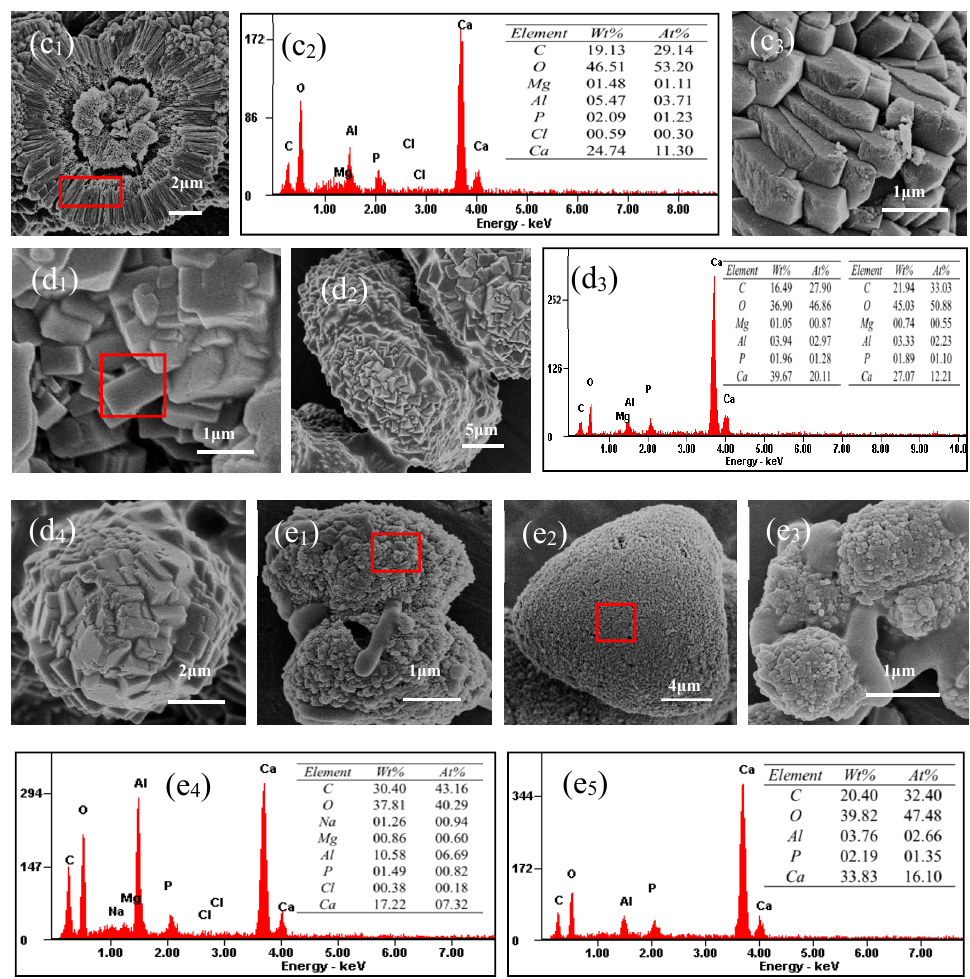
Figure 7. SEM and EDS analyses of minerals in MgCl 2 medium at different Mg/Ca ratios. ( a1 – a3 ) Mg/Ca ratio of 0; ( b1 – b3 ) Mg/Ca ratio of 2; ( c1 – c3 ) Mg/Ca ratio of 4; ( d1 – d4 ) Mg/Ca ratio of 6; ( e1 – e5 ) Mg/Ca ratio of 8.